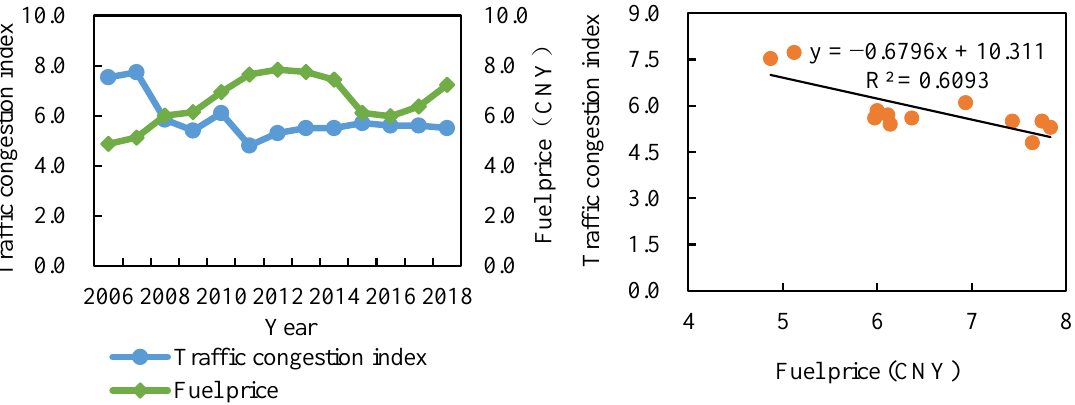
Figure 5. The relationship between fuel prices and the traffic congestion index for Beijing.